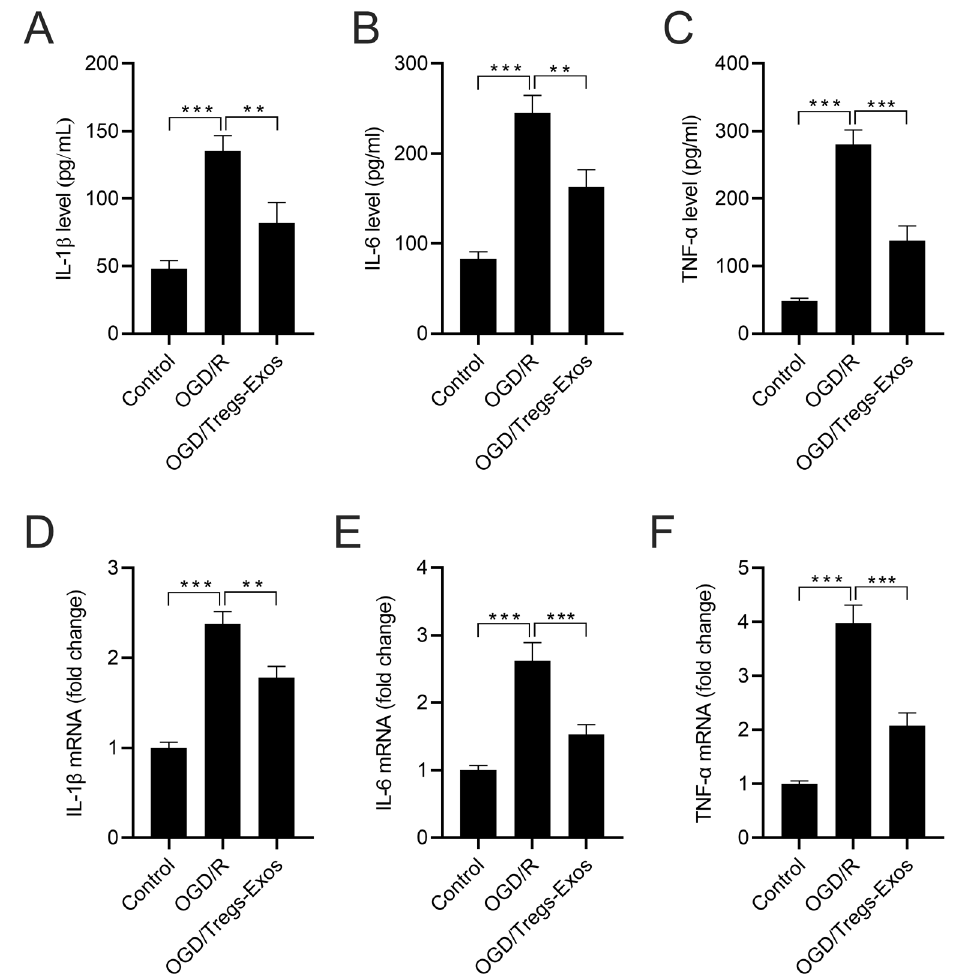
Figure 3 – Tregs-Exos mitigates OGD/R-induced secretion of inflammatory cytokines in BV-2 microglia. (A-C) ELISA assay was conducted to evaluate the levels of TNF-α, IL-1β, and IL-6. (D-F) mRNA levels of TNF-α, IL-1β, and IL-6 were detected by qRT-PCR assay. ** p < 0.01, *** p < 0.001.